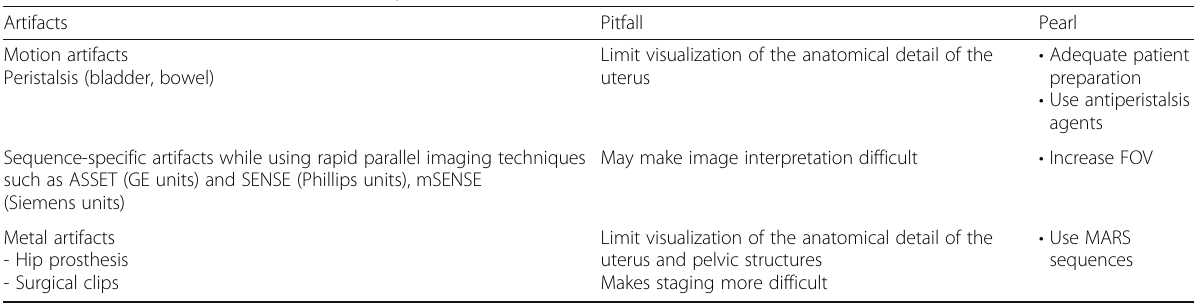
FOV field of view, MARS metal artifact reduction